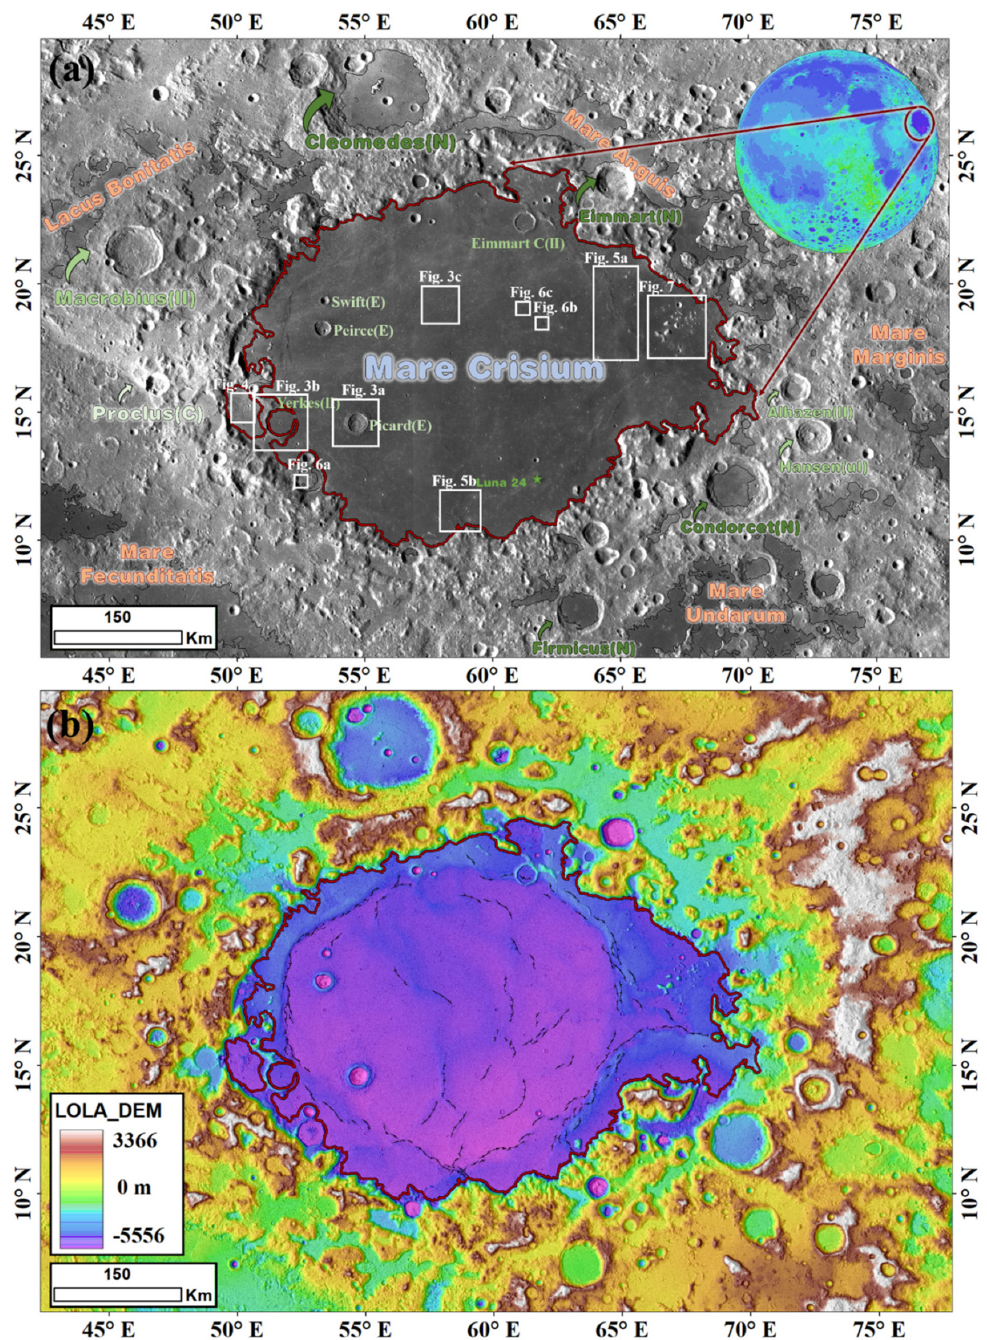
Figure 1. Location of the Crisium basin. ( a ) LROC WAC image showing the geological features (e.g., impact craters and mare plains). Mare boundaries are outlined from Nelson et al. (2014) [19]. The white boxes represent the locations of other Figures 2–7. ( b ) Topography of the Crisium basin. This image is an LOLA DEM data superposed on the LROC WAC